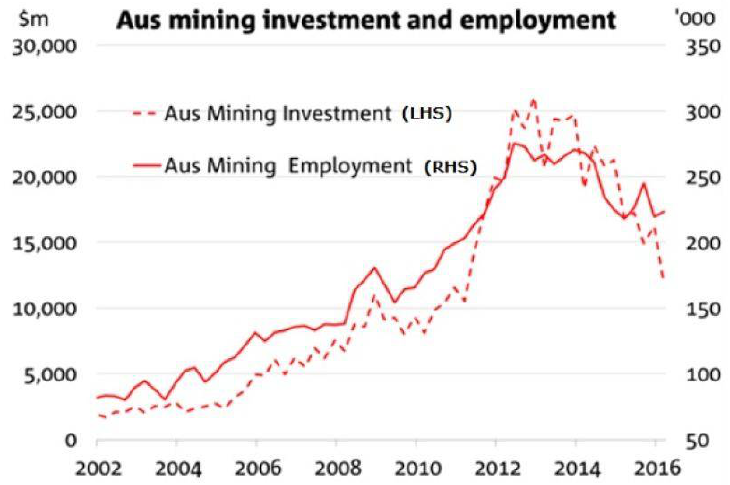
Figure 1. Australian mining investment and employment. Source: Letts 2016.